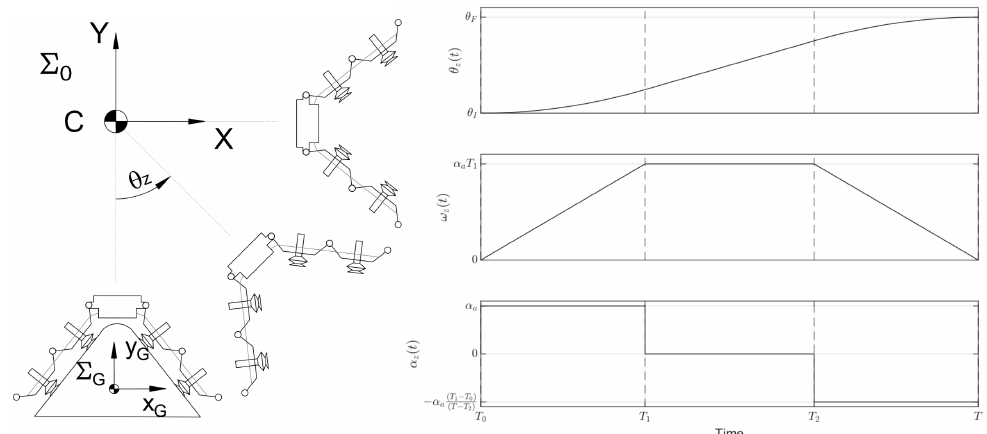
Figure 4. Example of trajectory for the